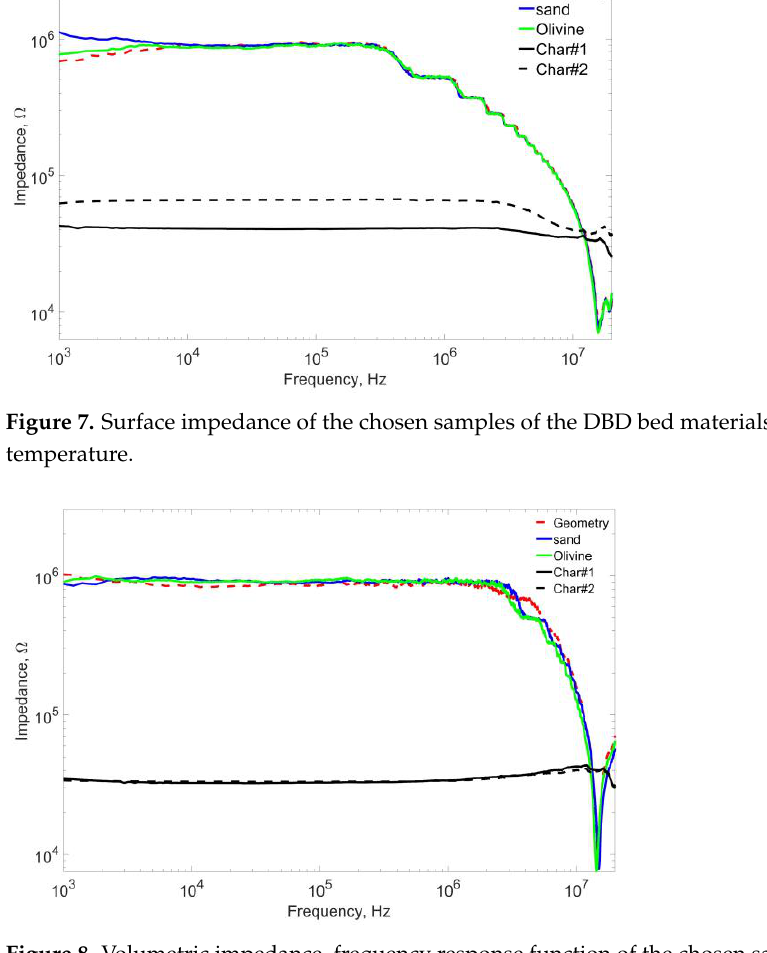
Figure 8. Volumetric impedance–frequency response function of the chosen samples of the DBD bed materials measured at ambient temperature. Table 3. Surface and volume electrical properties of the DBD bed materials measured at a higher